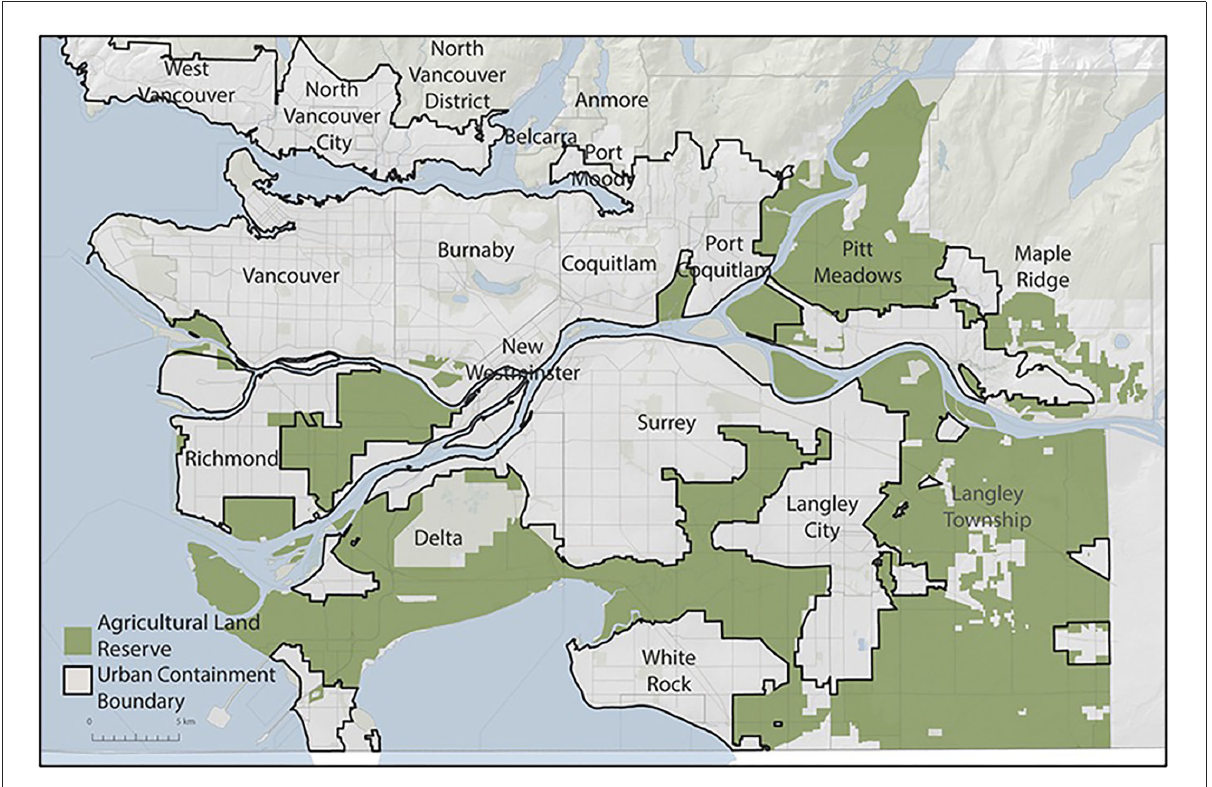
sectors, interpretation of farming issues and sectoral